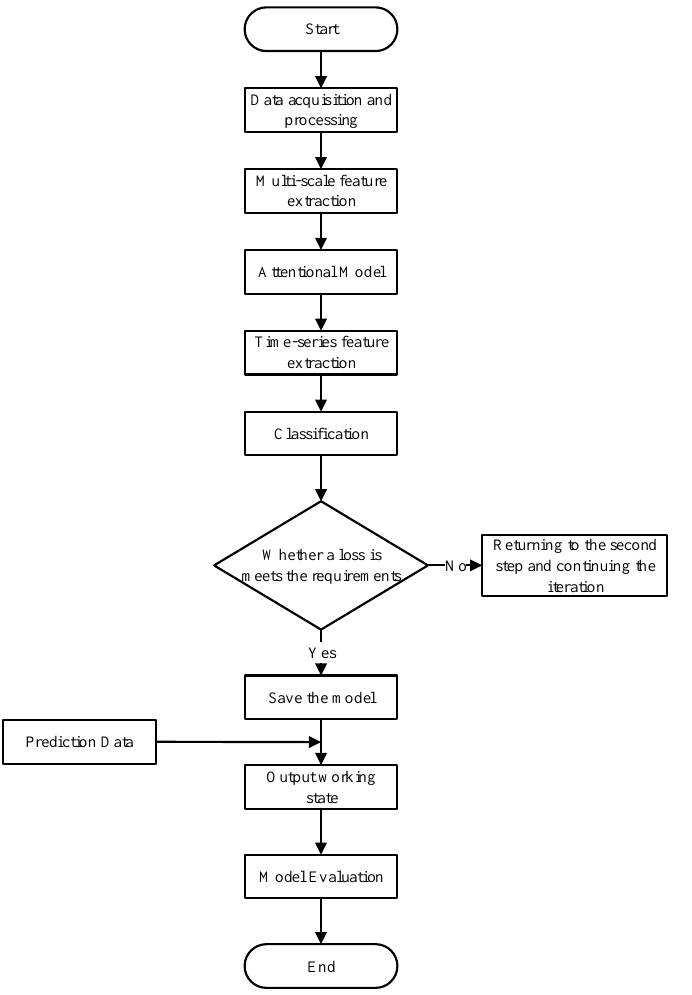
Figure 5. Flow chart of working condition recognition algorithm.